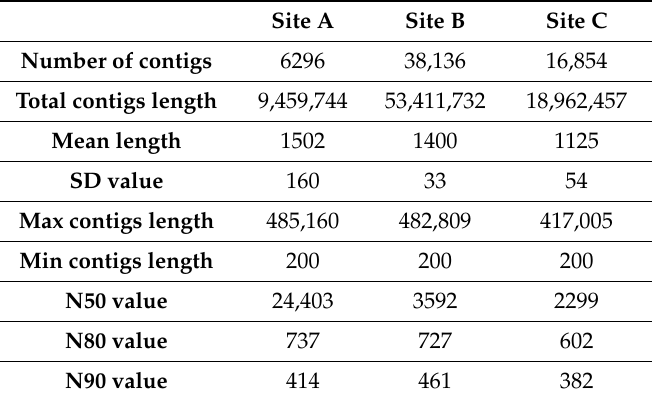
Table 2. Assembly